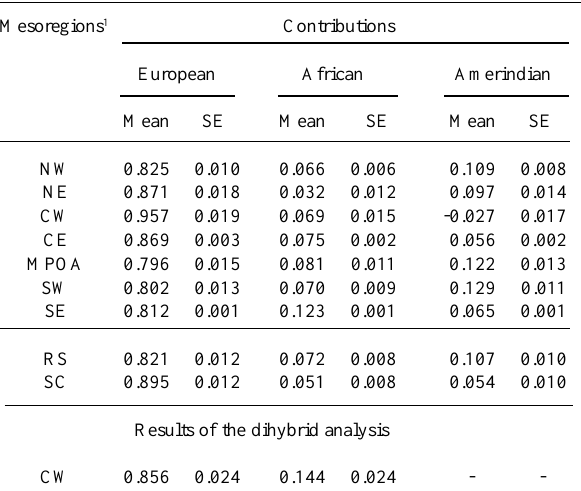
Table V - Estimated interethnic admixture in the European-derived populations of seven mesoregions of the State of Rio Grande do Sul (RS) and in Santa Catarina (SC).